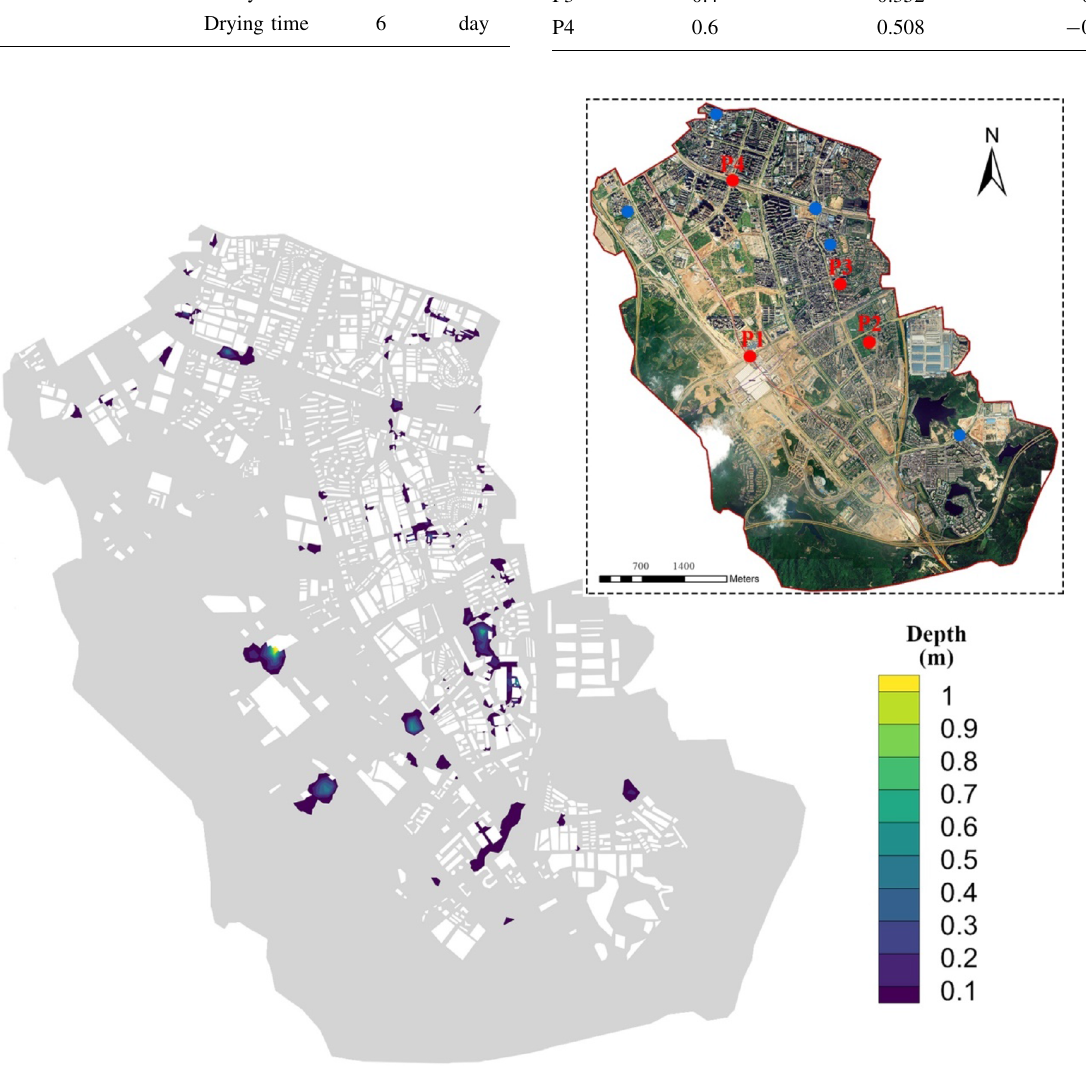
Fig. 7 Simulation results and the measured data from the study area (red dots: area with water depth data; blue dots: area without water depth data)